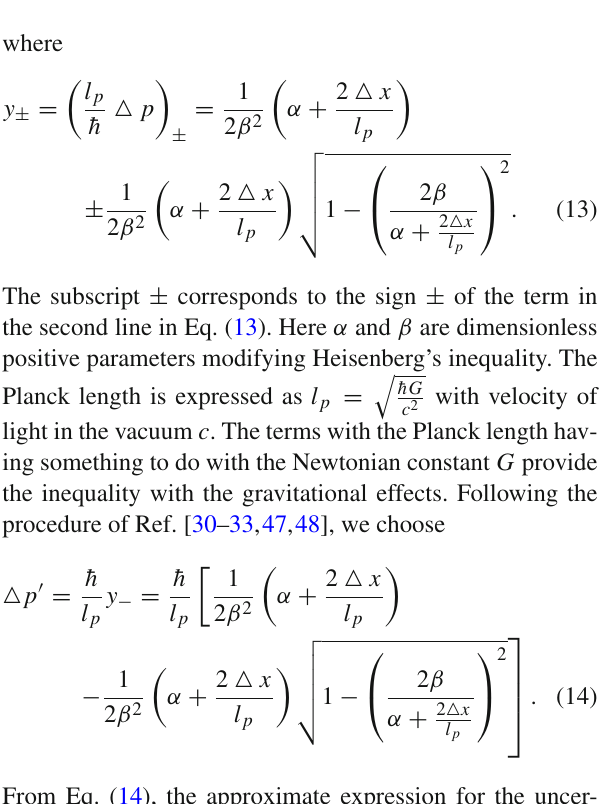
Fig. 1 The solid, dotted, dashed curves of the dependence of entropy difference (cid:4) S on ε M in units of π( GM ) 2 for ψ 0 = 0 . 05 , 0 . 1 , 0 . 12, respectively, without